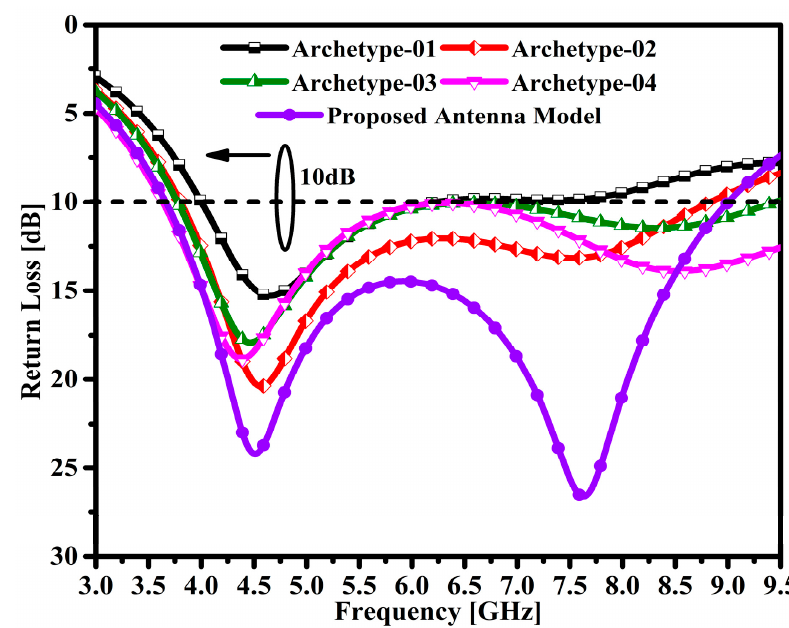
Figure 2. Corresponding return loss |S 11 | in the antenna design process.